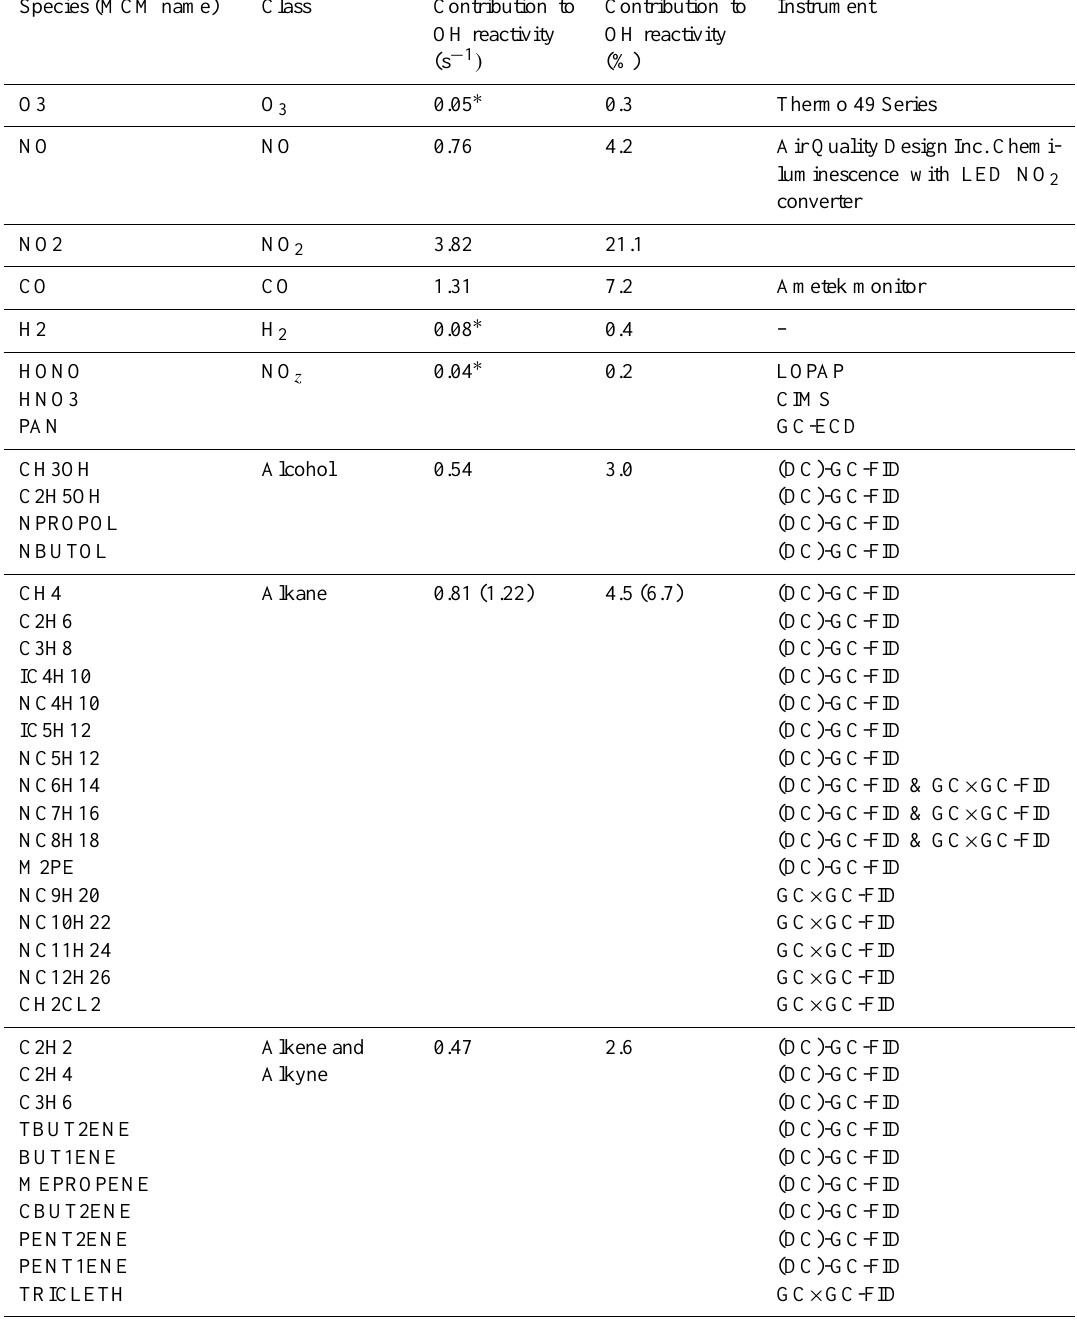
Table 1. Species used as input to the model, the class each species is grouped into, the average contribution (s − 1 and %) of each class to OH reactivity and the detection method for each species. The OH reactivity when the concentration of the unassigned GC considered is given in